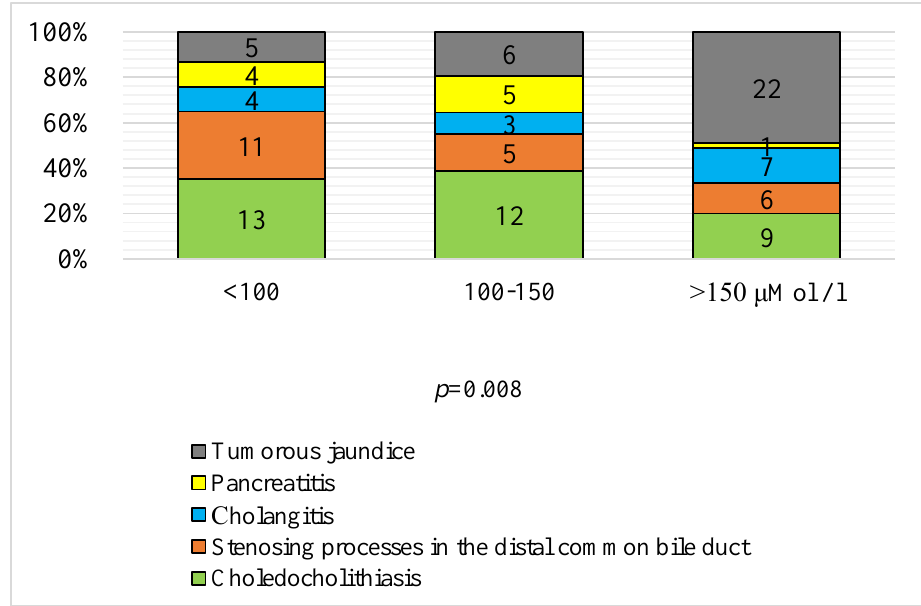
Figure 3. Distribution of patients with different causes of obstructive jaundice stratified by the level of hyperbilirubinemia after hospitalization ( p = 0.008); criterion X2 ( n = 113).